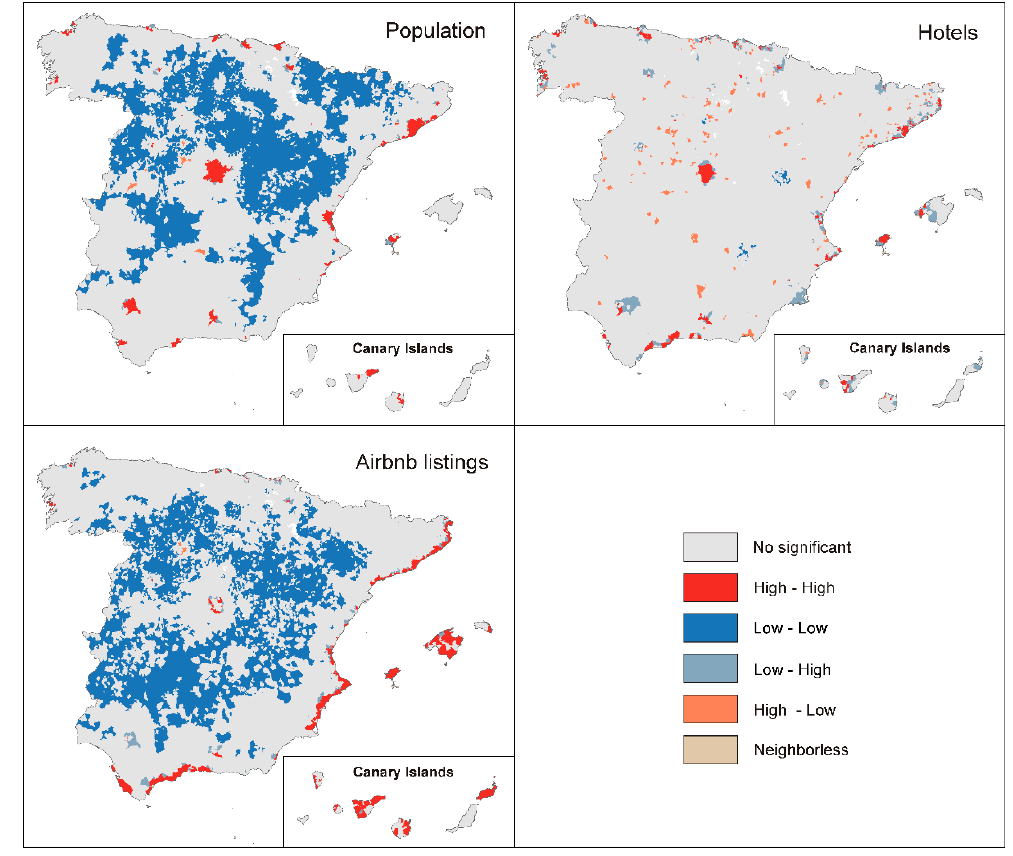
Figure 4. Cluster maps of univariate local Moran I.